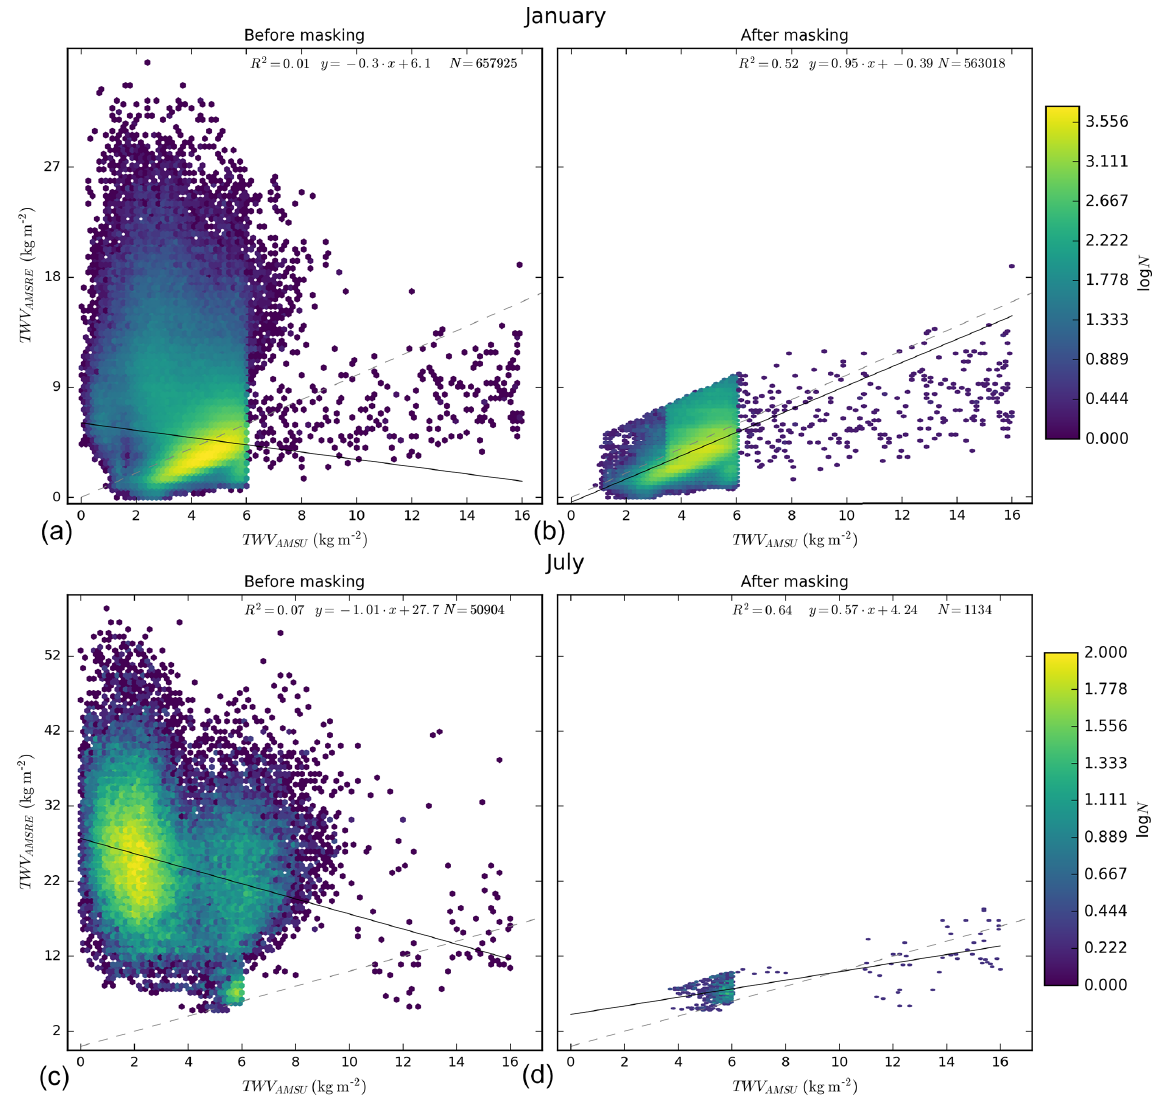
Figure 14. Density plot and fit for AMSR-E TWV vs. AMSU-B TWV retrievals for all the coincident points in January (a, b) and July (c, d) from 2006 to 2008, both before (a, c) and after (b, d) filtering AMSU-B retrieval for ice cloud artefacts, with a fit (solid black line) for the data clusters over the one-to-one line (dashed